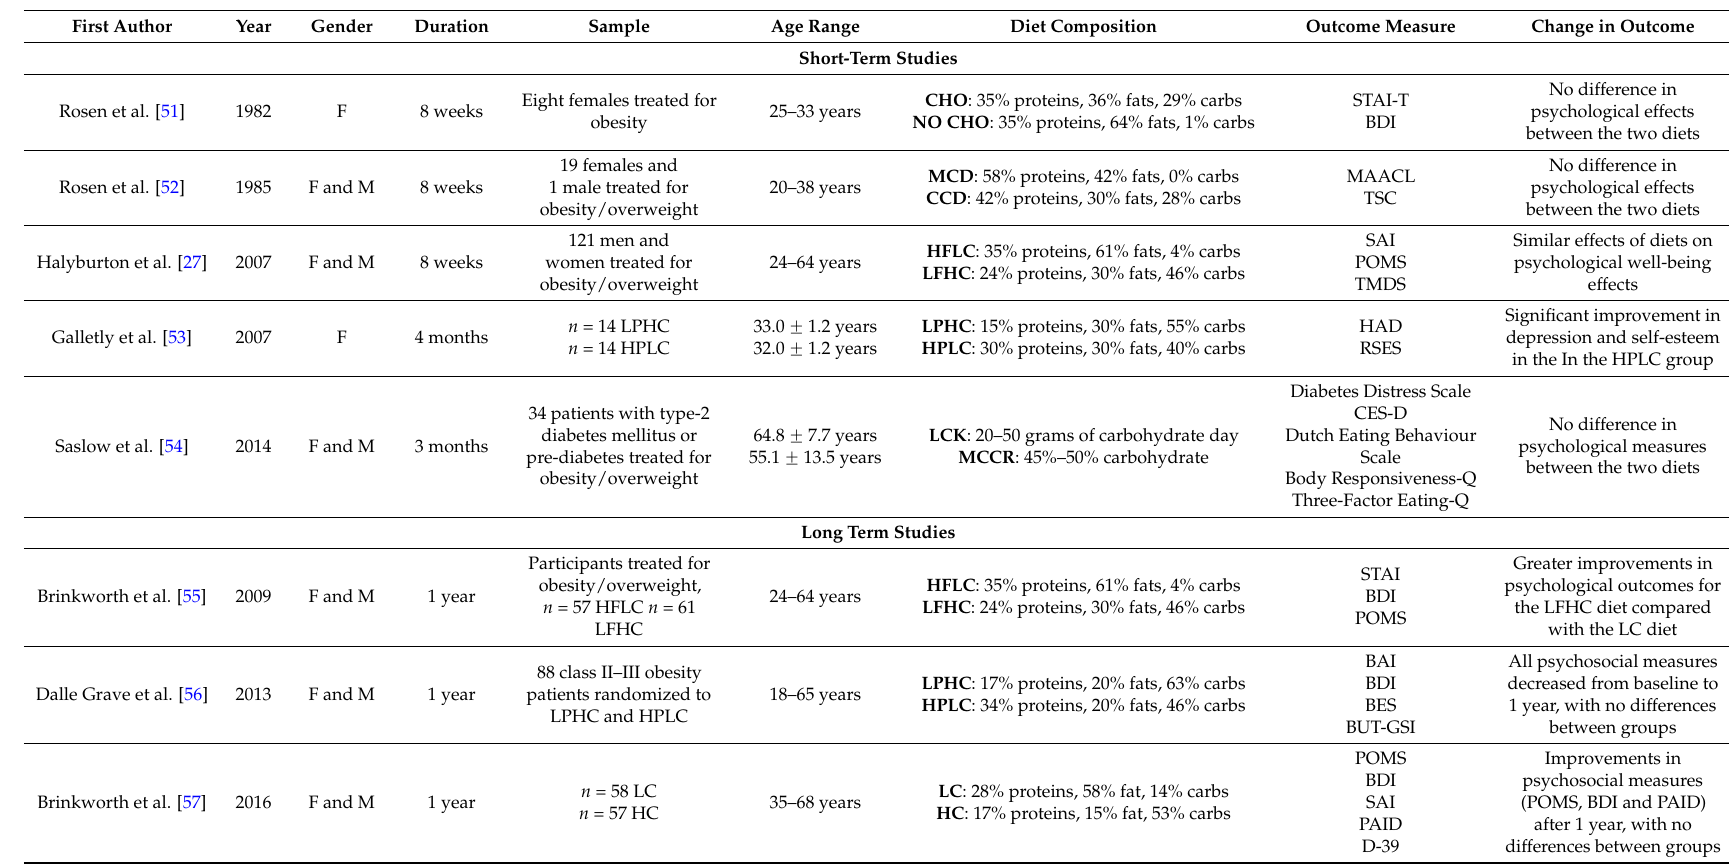
Table 1. Studies included in the systematic